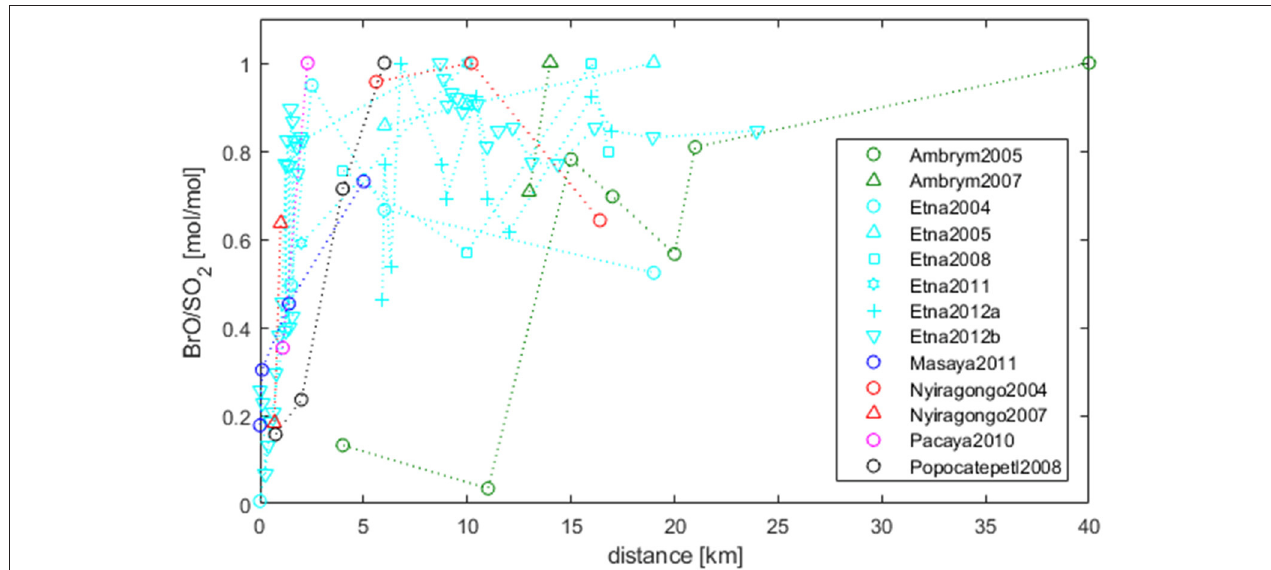
FIGURE 3 | Development of BrO/SO 2 -ratios (normalized) in the plume as a function of distance from the emission source [extended from Bobrowski and Giuffrida (2012) and Platt and Bobrowski (2015), using datasets in Supplementary Table 1 and references therein]. For data-series with the same distance averages are formed. BrO is not detectable at crater rims but typically rises to a near stable level within 5–10km (for details see section Dependence on Plume Age–Temporal